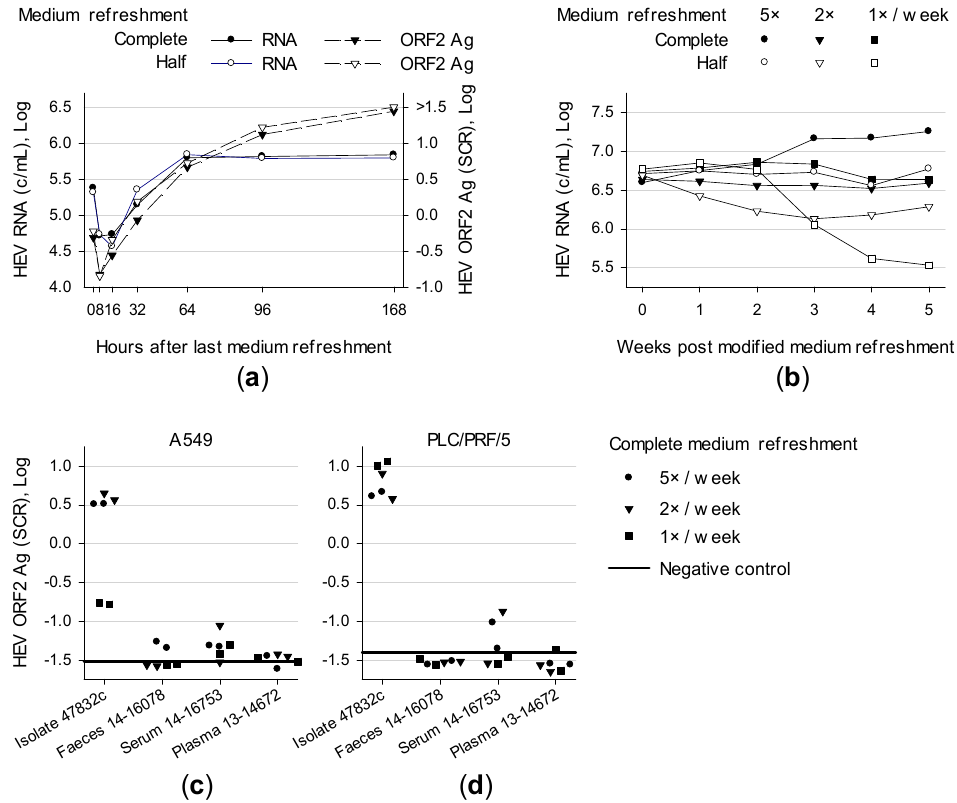
Figure 1. E ff ect of medium refreshment of cells persistently or de novo infected with HEV. ( a ) Supernatant of A549 persistently infected with HEV strain 47832c was refreshed either half or completely after lengthening time points and tested for HEV RNA and ORF2 antigen (Ag). ( b ) Supernatant of A549 persistently infected with HEV strain 47832c was either changed half or completely once, twice or five times a week and tested weekly for HEV RNA. ( c ) A549 and ( d ) PLC / PRF / 5 were inoculated in technical duplicates with isolate 47832c as well as with HEV-positive materials from three di ff erent patients, namely a faecal suspension 14-16078, serum 14-16753 and plasma 13-14672. After inoculation, medium was changed completely once, twice or five times a week and supernatants were tested for HEV ORF2 Ag 24 days post-inoculation (dpi). SCR, signal-to-cut-o ff